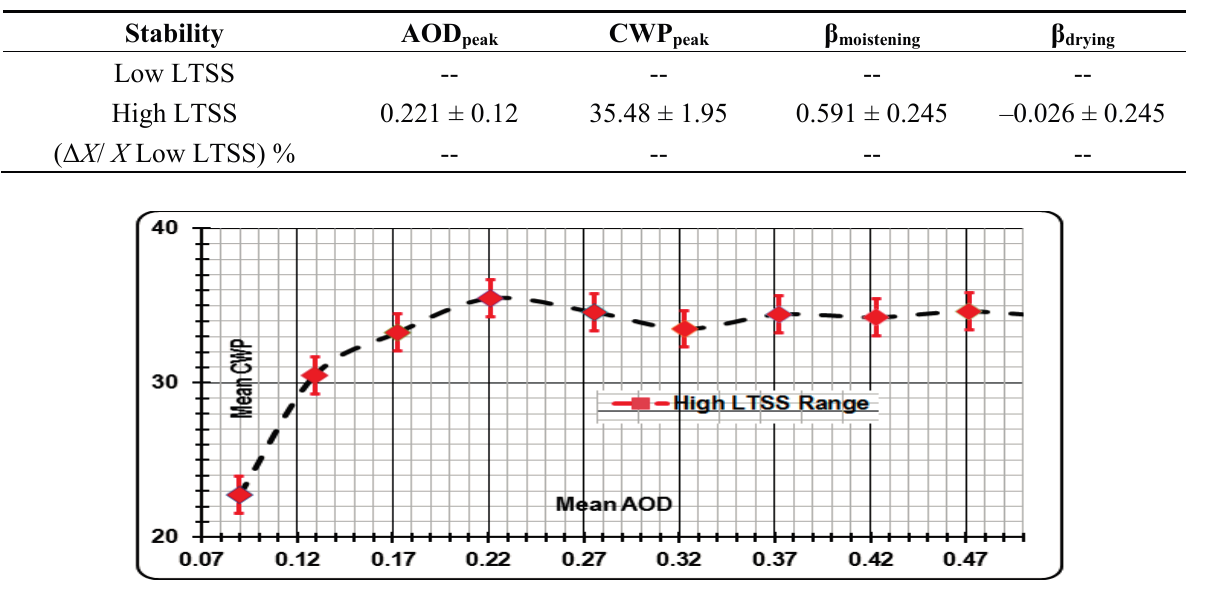
Figure 15. Response of cloud water path (CWP) to increasing aerosol optical depth (AOD) for high lower tropospheric static stability (LTSS) (stable atmospheric conditions). No data was available for low LTSS, possibly due high subsidence in the